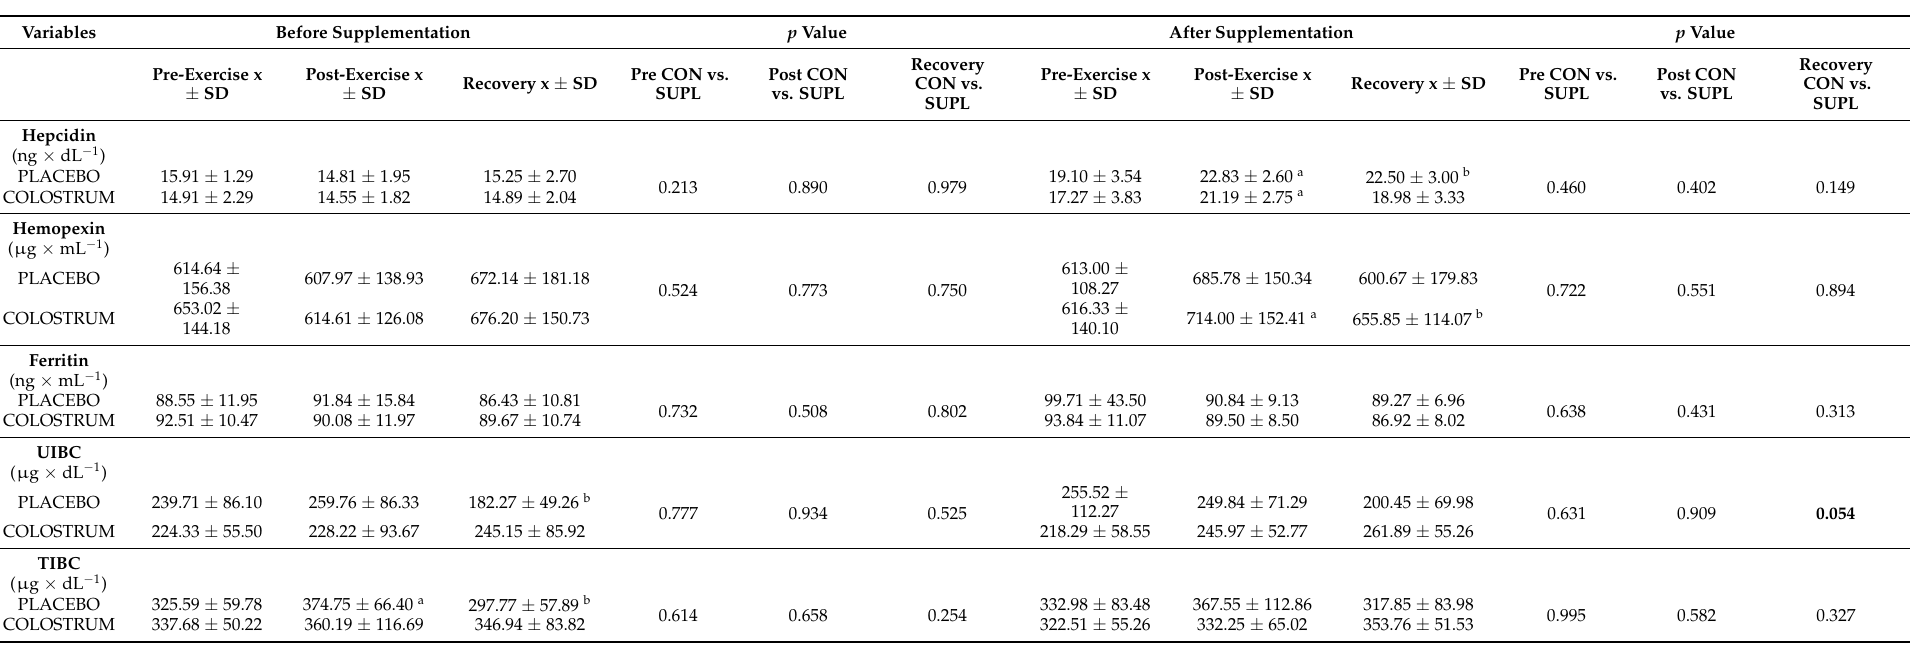
Table 3. Concentrations of Hepcidin, Hemopexin, Ferritin, UIBC, and TIBC of athletes supplemented with colostrum bovine and with